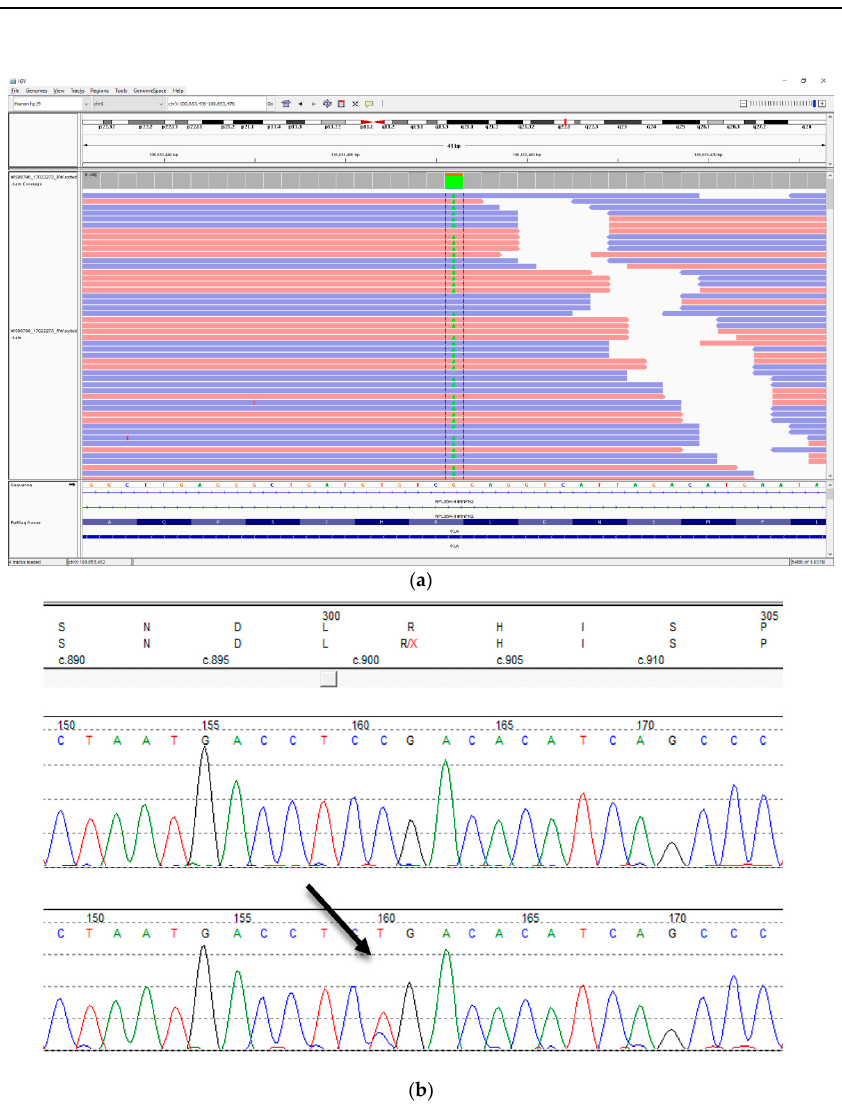
Figure 4. ( a ). NGS reads demonstrating biallelic presence of the variant (reverse strand read, i.e., G > A). ( b ). Sanger sequence trace with GLA c.901C>T variant (arrow). To determine more fully the biochemical effects of the genotype, the biochemical test- ing was repeated. Plasma α -Gal A level was below the normal range at 1.4 micromol/L/h, as was the leukocyte level at 1.4 micromol/L/h (range 10–50). Urine globotriaosylceramide (Gb3) 0.86 mg/mmol creatinine (normal 0–0.03) and plasma globotriaosylsphingosine (lyso-Gb3) 20.7 ng/mL (normal 0–1.8) were measured. Both were elevated, consistent with a diagnosis of Fabry disease. A reverse phenotyping of the proband established that he had experienced occa- sional episodes of non-limiting acroparaesthesia in his left hand. These had been at- tributed to his occupation as a truck driver. There was no evidence of angiokeratoma. His renal function revealed CKD stage 2 with a glomerular filtration rate (GFR) of 86